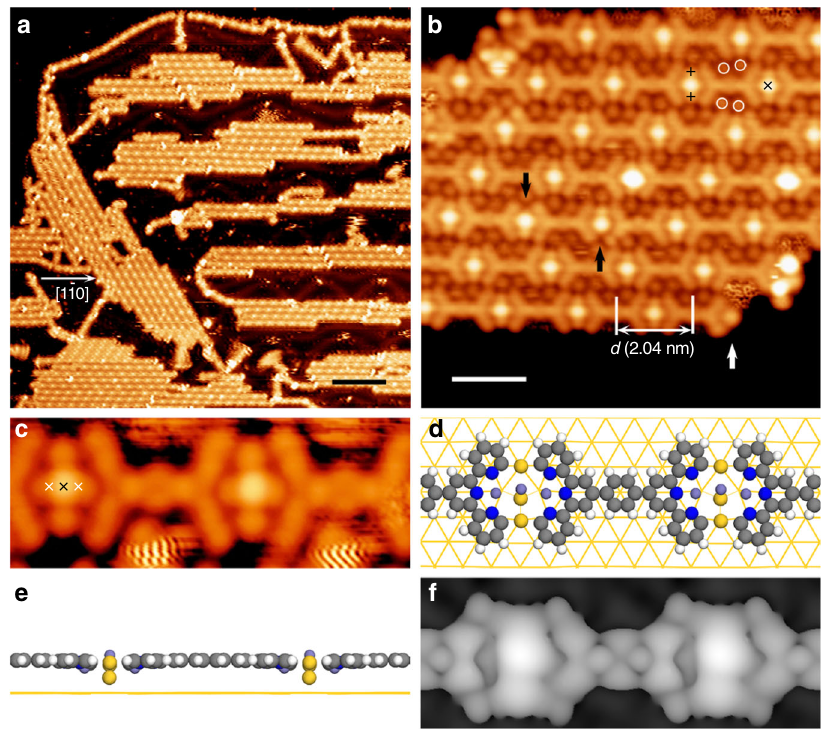
Fig. 5 C-Au organometallic intermediates after annealing at 397 – 566 K. a Overview of the organometallic chains after annealing at 487 K. b Close inspection of the chain structure. Black arrows denote the missing of Au atoms. The white arrow marks a debrominated tpy end. Three types of spots are marked by different symbols (plus sign + , cross sign × and circle ○ ). c High-resolution STM image ( U = − 0.05 V) of the chains (4.1 × 1.6 nm 2 ). Additional Fe atoms, as marked by white “ × ” , are resolved. d – f DFT optimized structure of the organometallic chain: top view ( d ), side view ( e ) and simulated STM topograph ( U = -0.05 V) ( f ). Fe, purple; Au adatom, yellow; C, gray; H, white. Scale bars: ( a ) 10 nm; ( b ) 2 nm. Data acquisition conditions ( T = 293